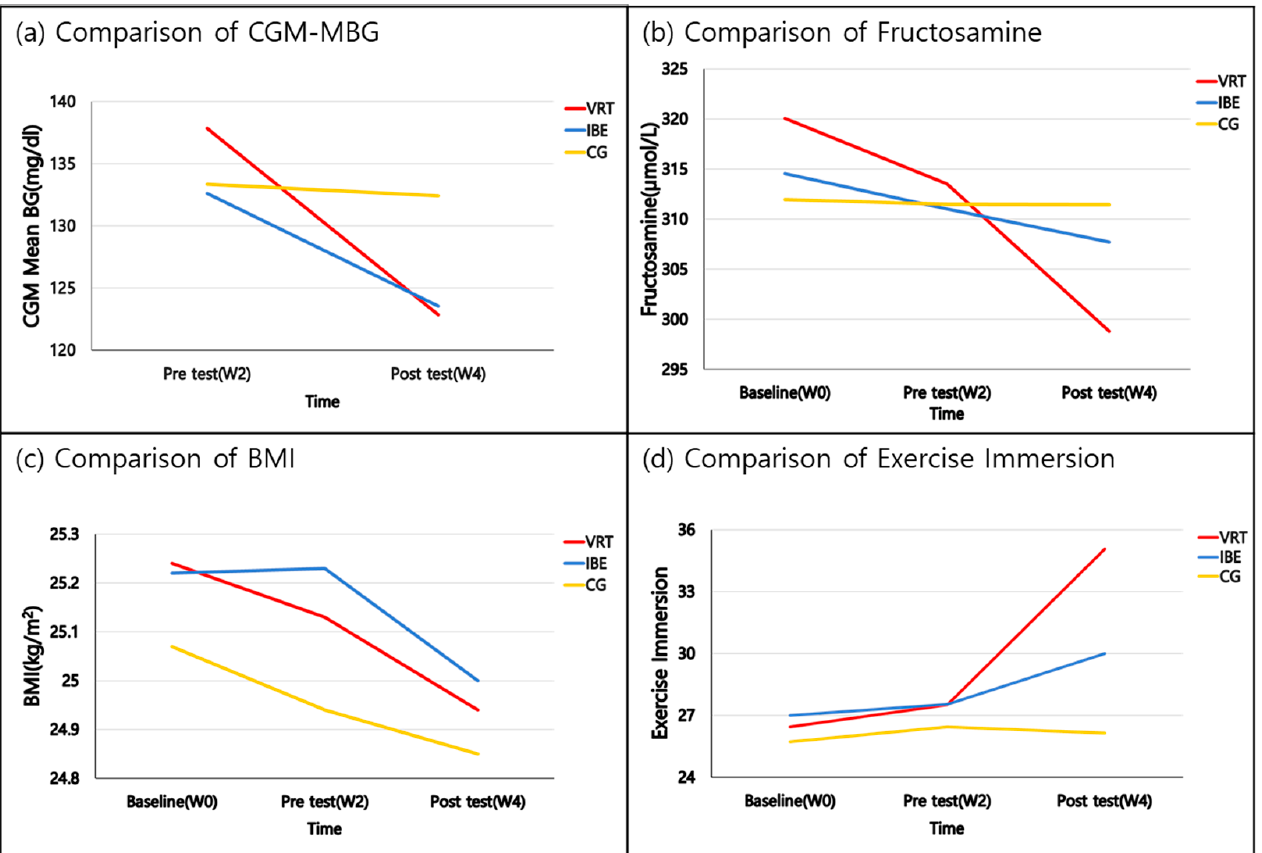
Figure 3. Comparison of blood glucose, body composition, and exercise immersion between the groups. Baseline (W 0 ): baseline measurements. Pre-test (W 2 ): measurements two weeks before the intervention. Post-test (W 4 ): measurements two weeks after the intervention. VRT: Virtual reality therapy group; IBE: indoor bicycle exercise group; CG: control group; CGM-MBG: continuous glucose monitoring mean blood glucose; BMI: body mass index.